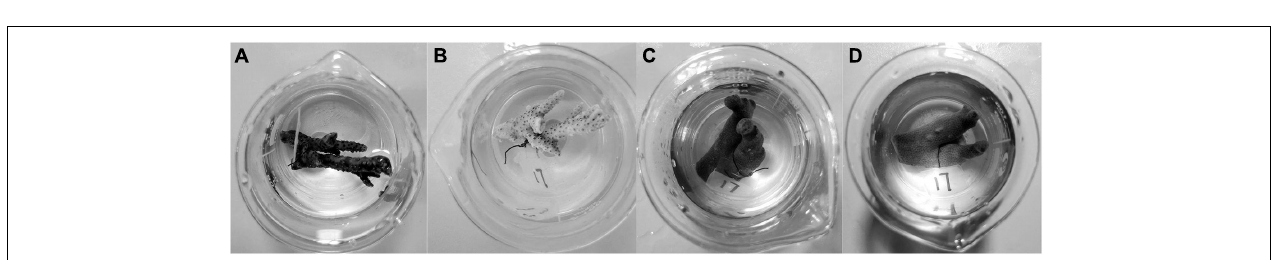
FIGURE 1 | Relative abundance of zooxanthellae types for A. hyacinthus (Ah1a-Ah1f) and P. cylindrica (Pc0a-Pc0f). Six samples were taken from each species for analysis.